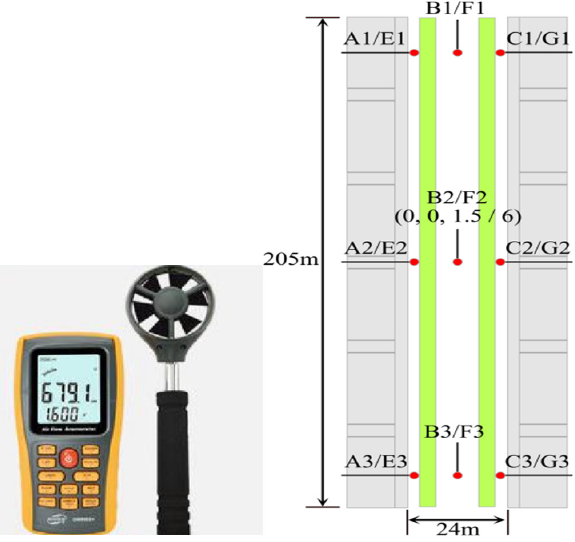
Figure 2. Anemometer and monitoring points.